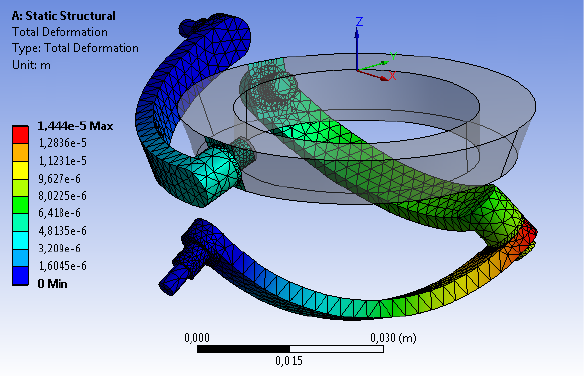
Figure 2. Prototype of the parallel spherical wrist.